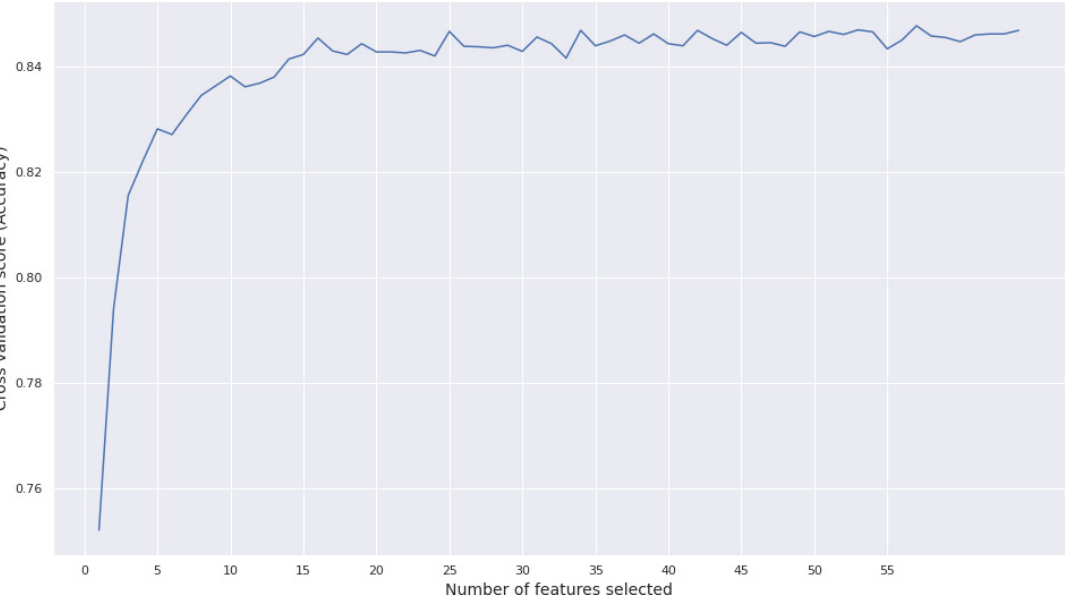
Figure 5. RFECV score vs. number of features.